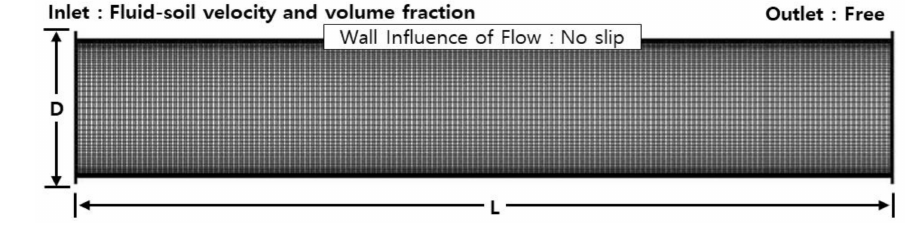
Figure 5. Conduit mesh. Table 4. Parameters of standard k – ε